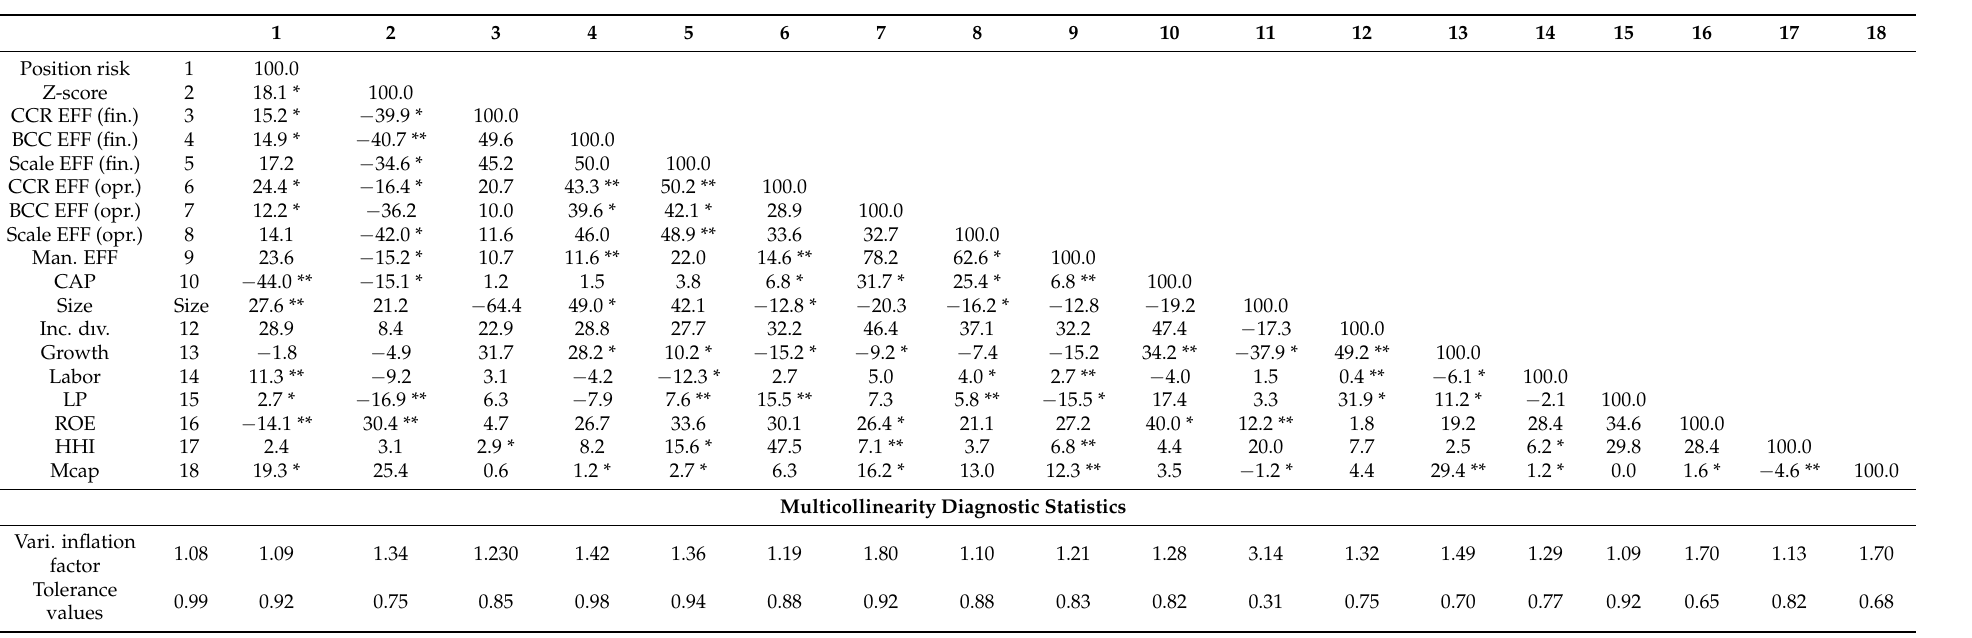
Table 7. Correlation matrix of